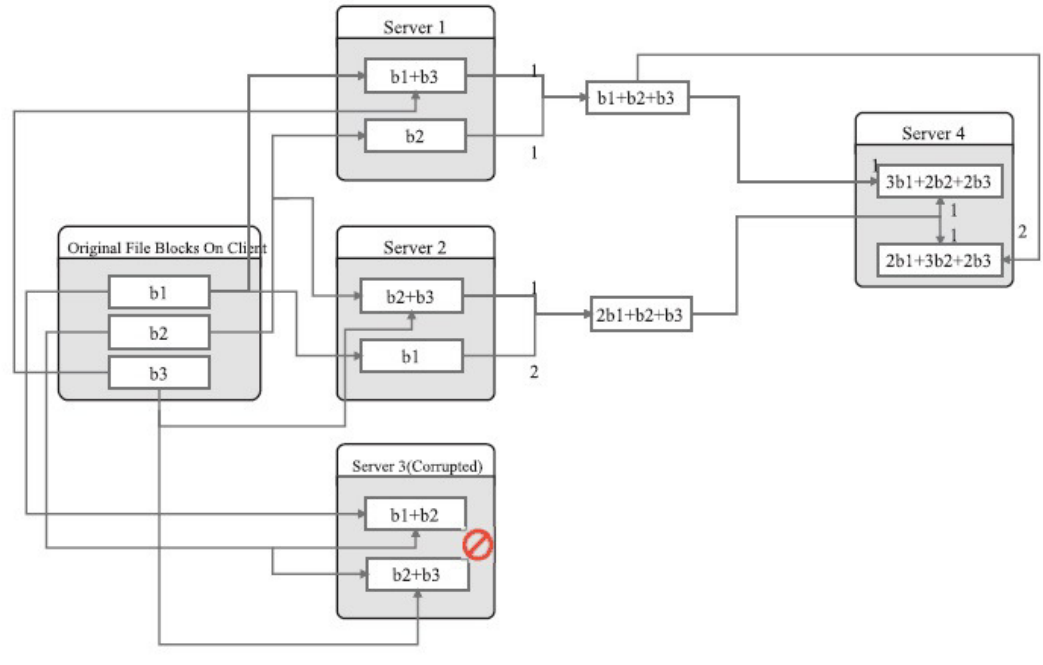
Fig. 7 Network Coding-Based Distributed Storage